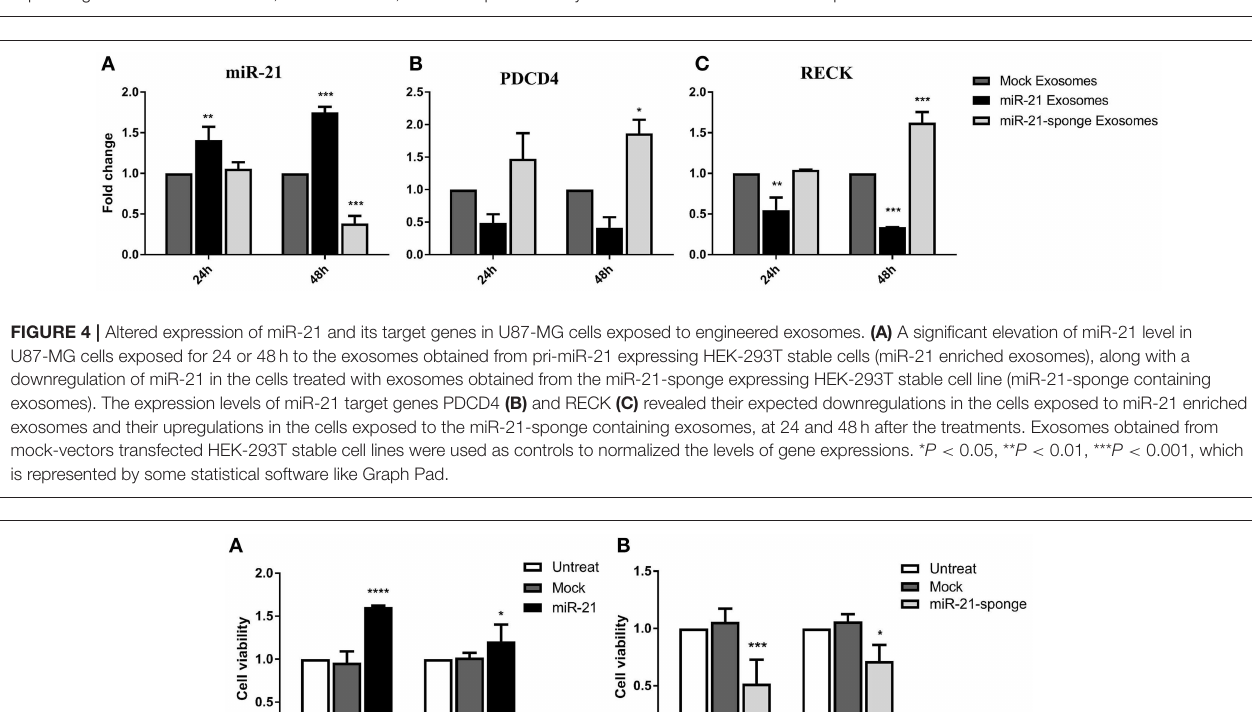
FIGURE 3 | miR-21 levels in extracted exosomes from miR-21 and miR-21-sponge expressing HEK-293T cells. (A) Log2 of miR-21 levels in extracted exosomes from stable HEK-293T cells exogenously expressing miR-21, in comparison with exosomes extracted from HEK-293T cells expressing mock-pLentiIII, revealed a significant elevation in miR-21 level ( P < 0.0001). Similarly, miR-21 level demonstrated a significant decline in extracted exosomes obtained from miR-21-sponge expressing HEK-293T cells, compared to the exosomes extracted from HEK-293T cells stably expressing mock-Tracer vector ( P < 0.0001). (B) The packaging of miR-21-sponge in exosomes extracted from miR-21-sponge expressing HEK-293T stable cell line, note that its expression was undetermined in HEK-293T expressing mock-Tracer. * P < 0.05; **** P < 0.0001, which is represented by some statistical software like Graph Pad.